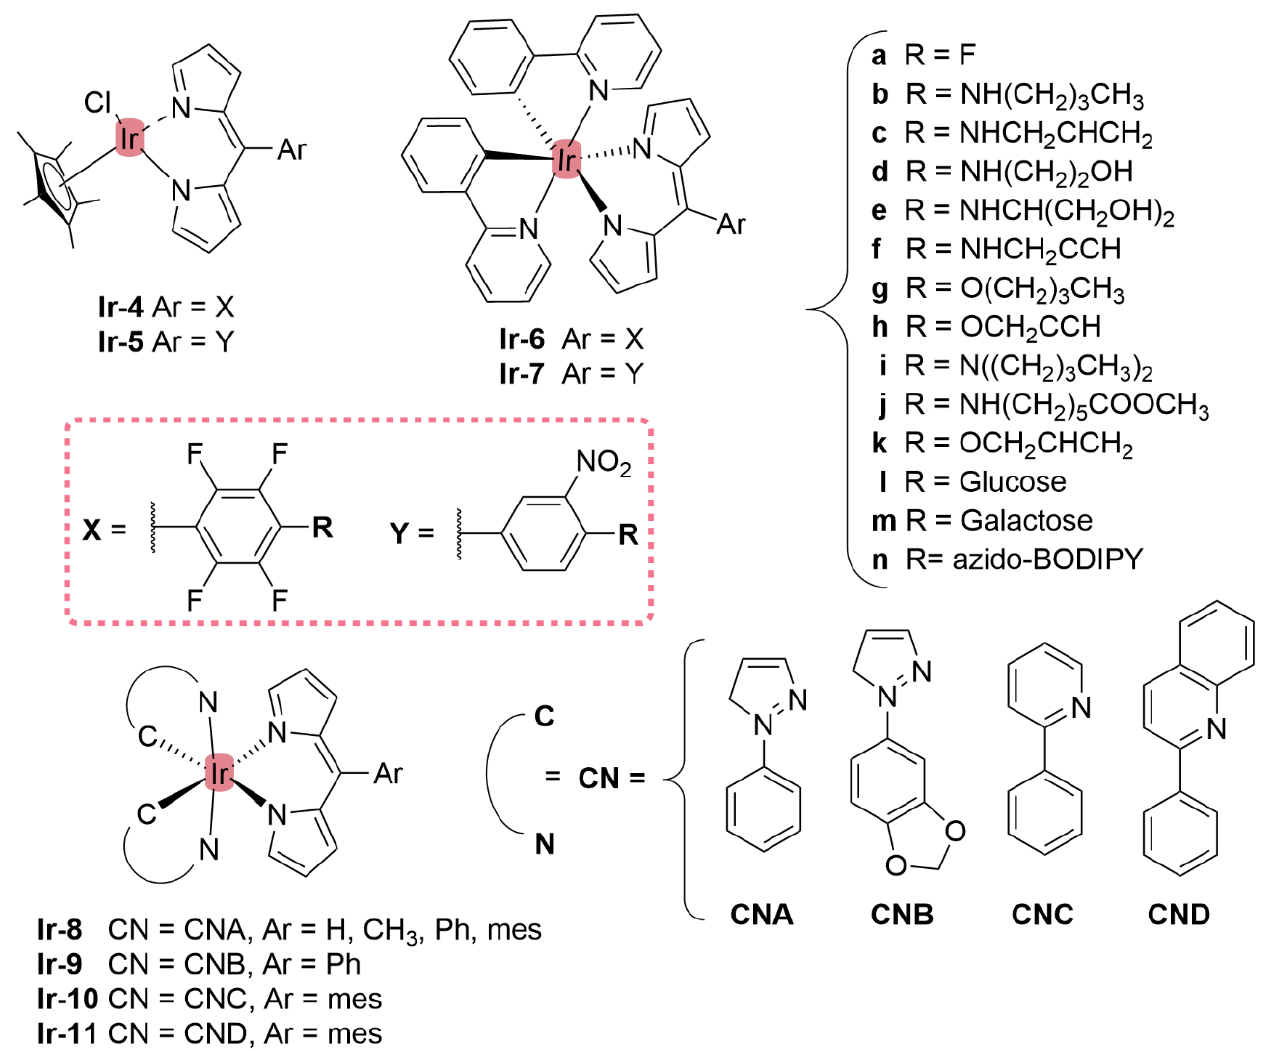
Figure 15. Chemical structures of heteroleptic (dipyrrinato)Ir(III) complexes.